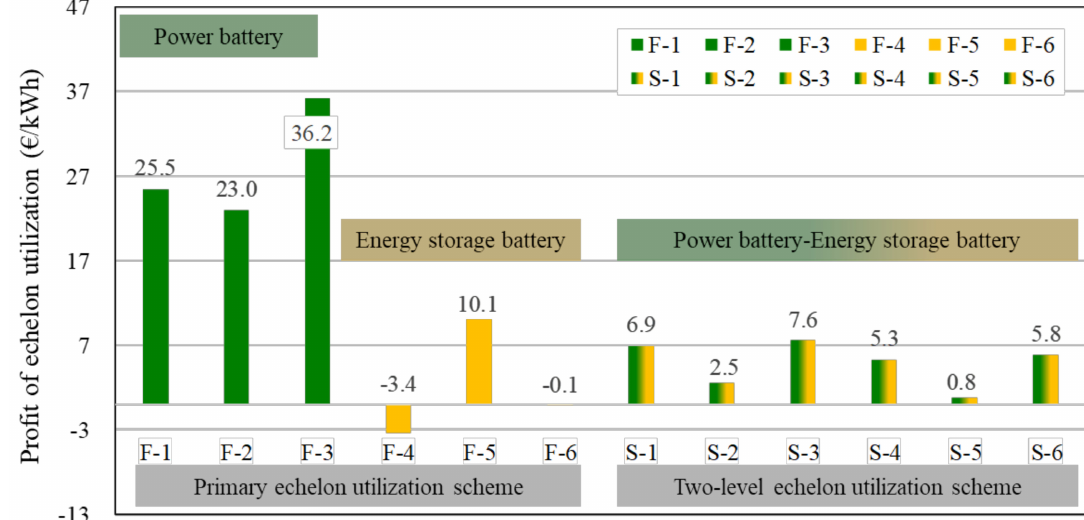
Figure 7. Comparison of economic benefits of the di ff erent echelon utilization